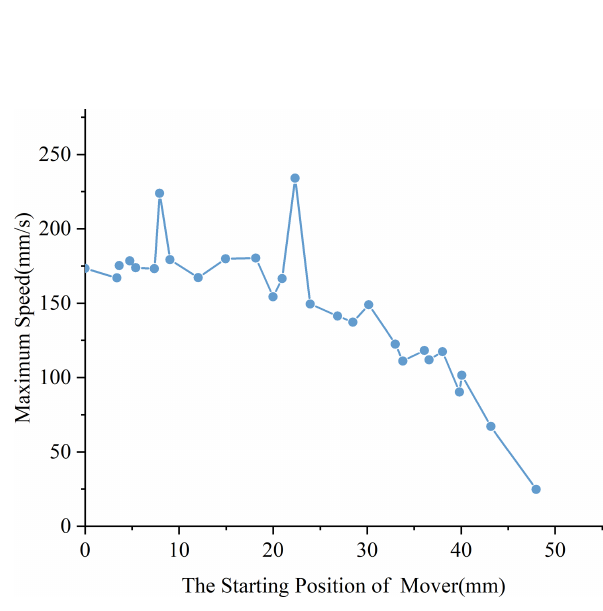
Figure 15. Maximum speed at different starting